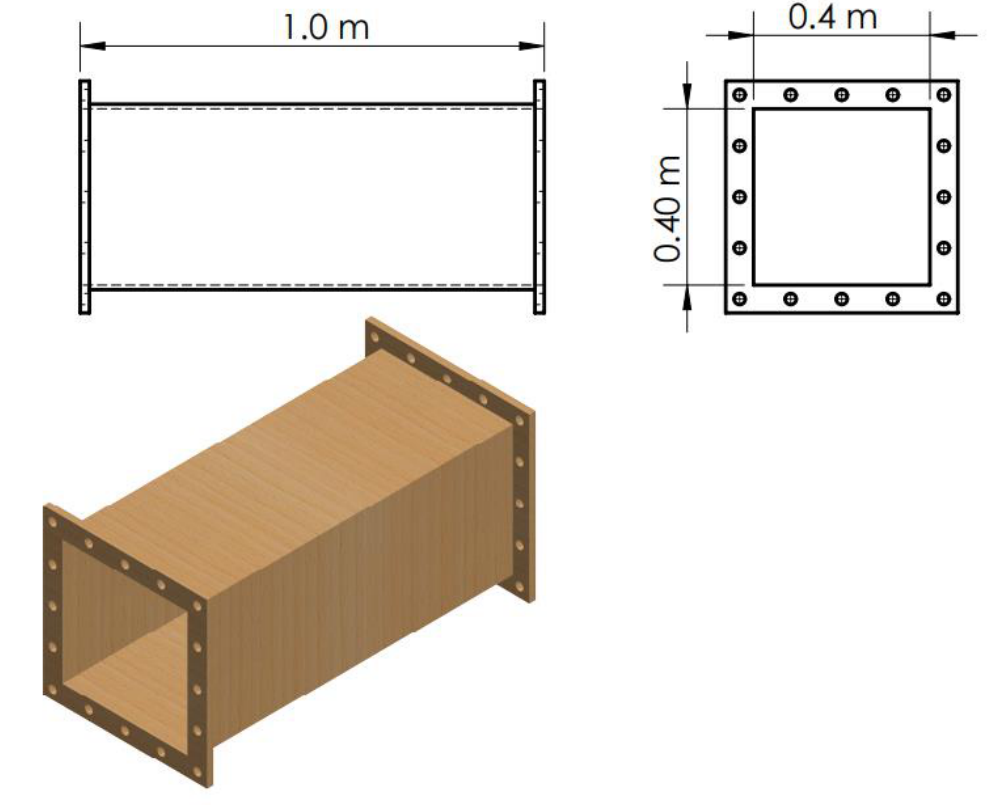
Figure 3. The 3-D model of the test section.